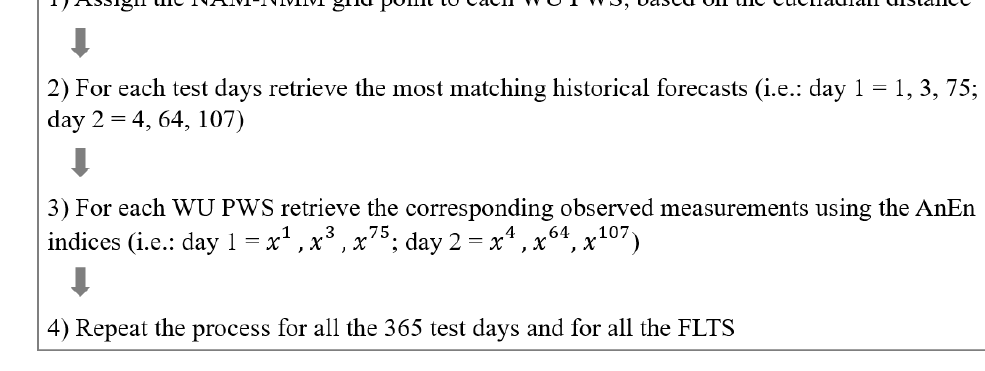
Figure 5. Main steps of the proposed downscaling indices method. In bullet point three, x j indicates the historical observation, and j represents the historical